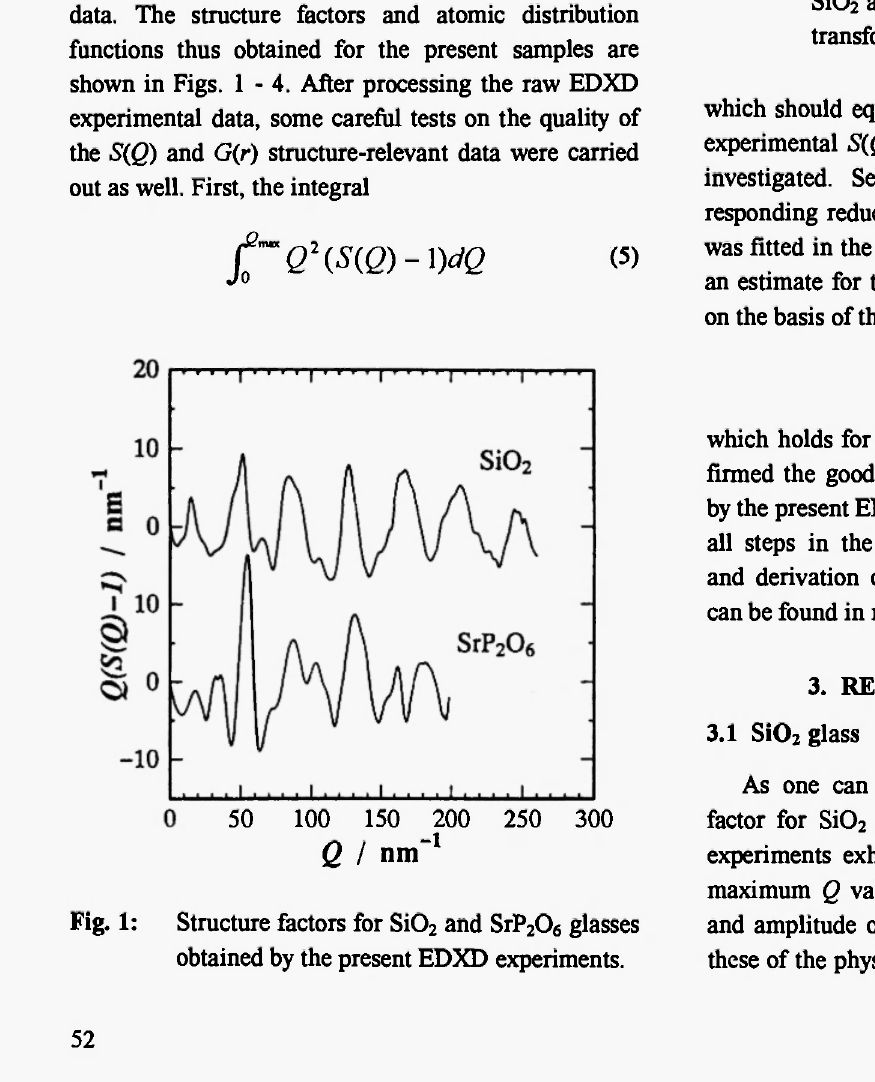
Fig. 2: Reduced radial distribution functions for Si0 and SrP 0 glasses obtained by Fourier 2 2 6 transformation of 5 (0 of Fig.